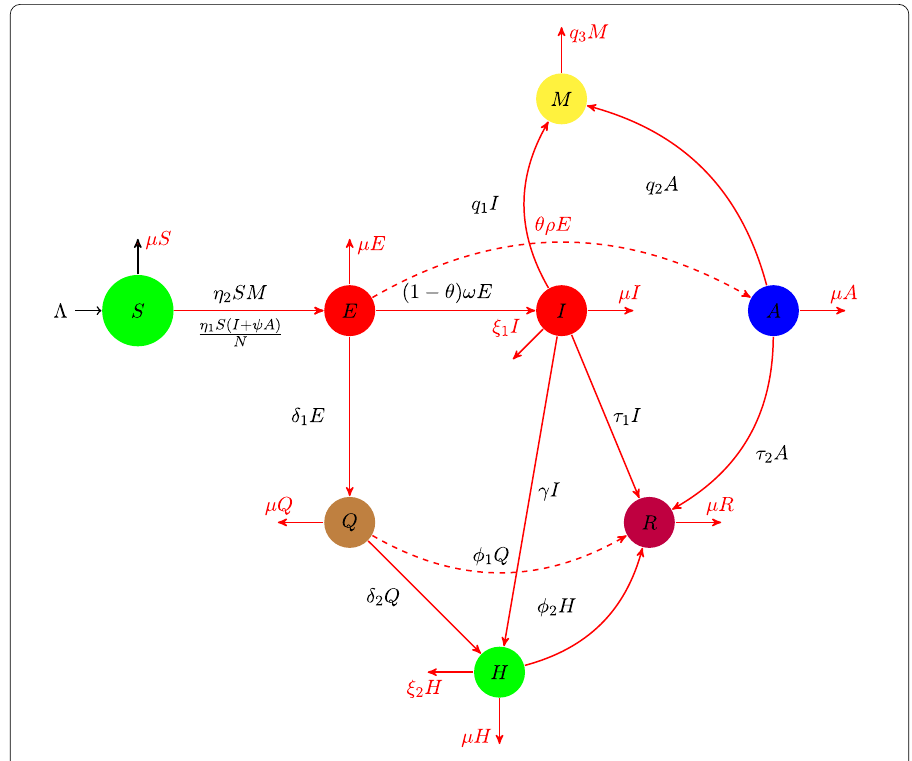
Figure 1 The description of the flow rate of the parameters of the